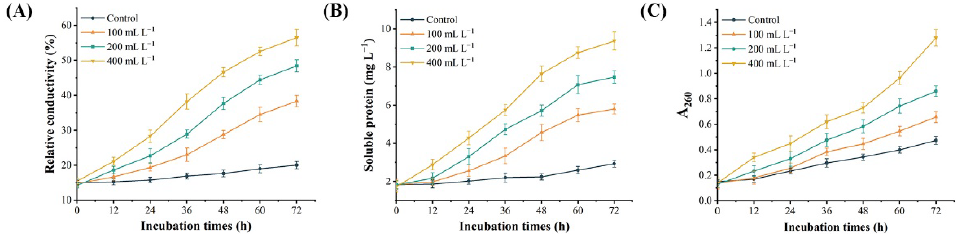
Figure 4. Dynamic changes of relative conductivity ( A ), soluble protein ( B ), and nucleic acid ( C ) in Didymella glomerata culture medium treated with SS for 72